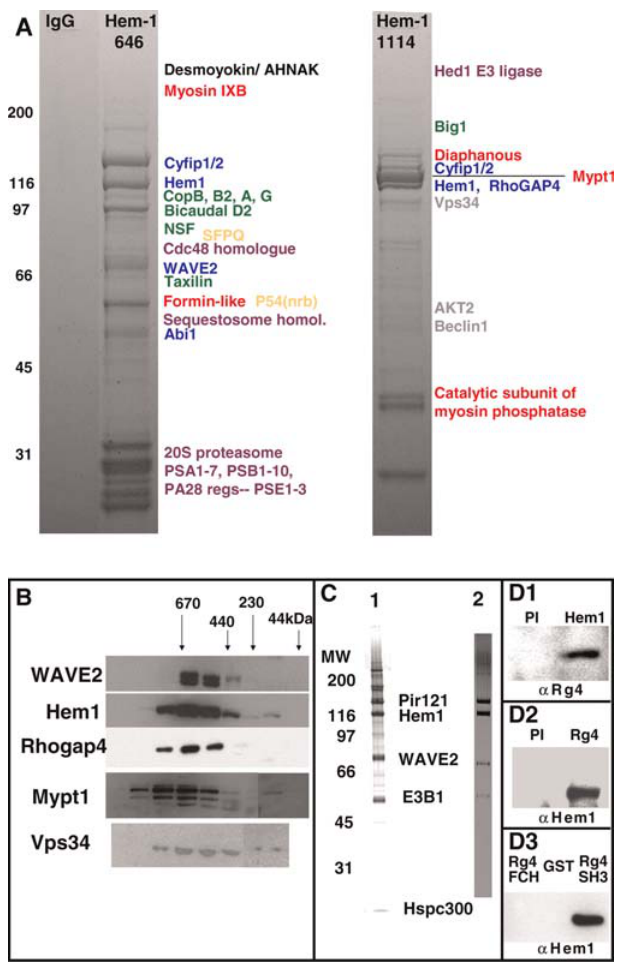
Figure 3. Antibodies to the Hem-1 Component of the WAVE Regulatory Complex Immunoprecipitate Potential Polarity Effectors in Addition to the WAVE2